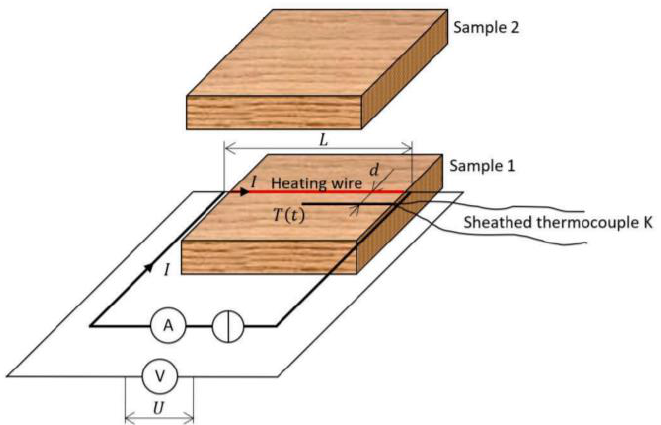
Figure 20. Schematic diagram of hot wire method.